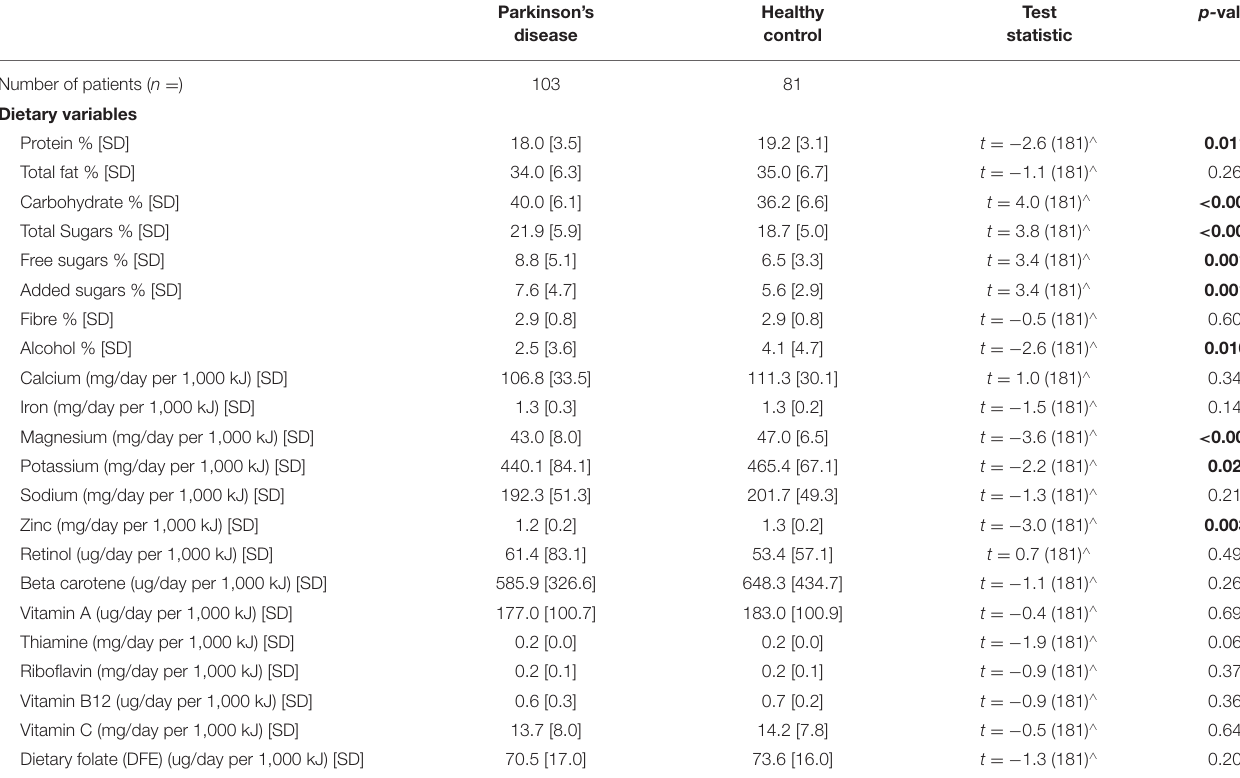
TABLE 3 | Intake of macronutrients expressed as percentage of energy intake and intake of micronutrients expressed per 1,000 kJ intake.